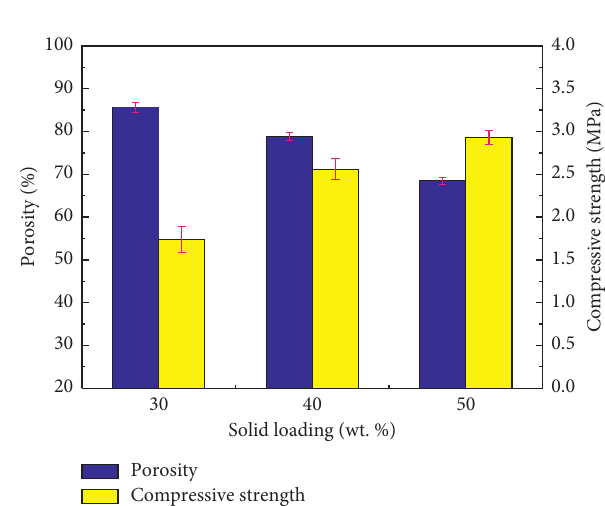
Figure 5: Effect of solid loading on properties of steel slag foam ceramics.